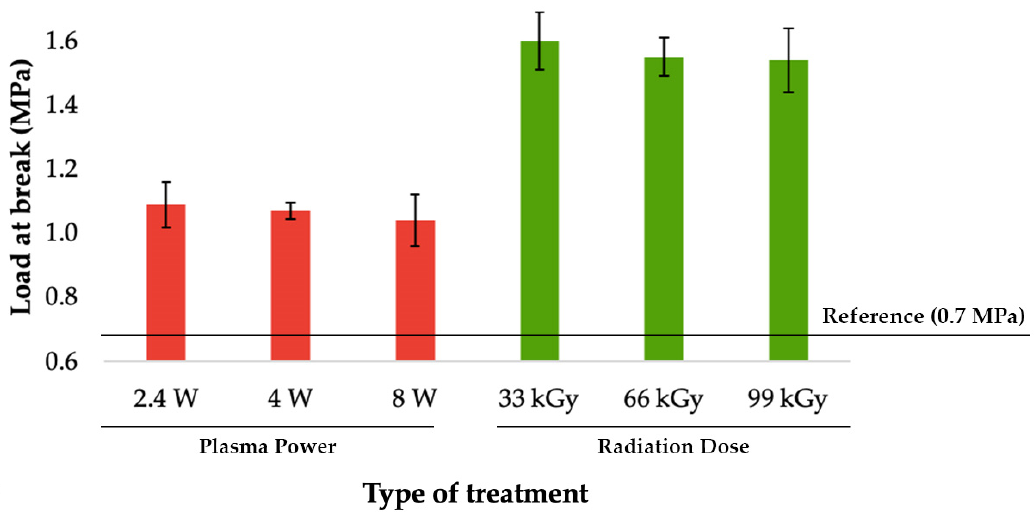
Figure 6. Load-bearing of adhered joints for cyanoacrylate adhesive (depending on plasma power and radiation dose).